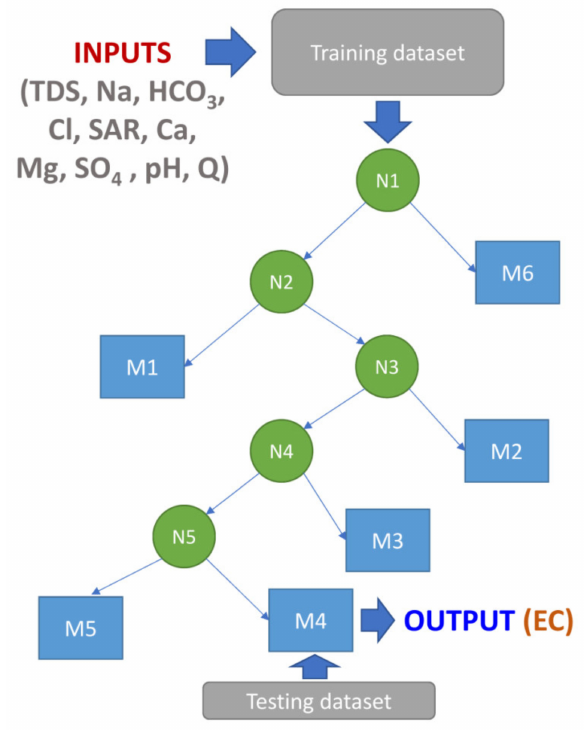
Figure 2. An example M5P tree model for predicting electrical